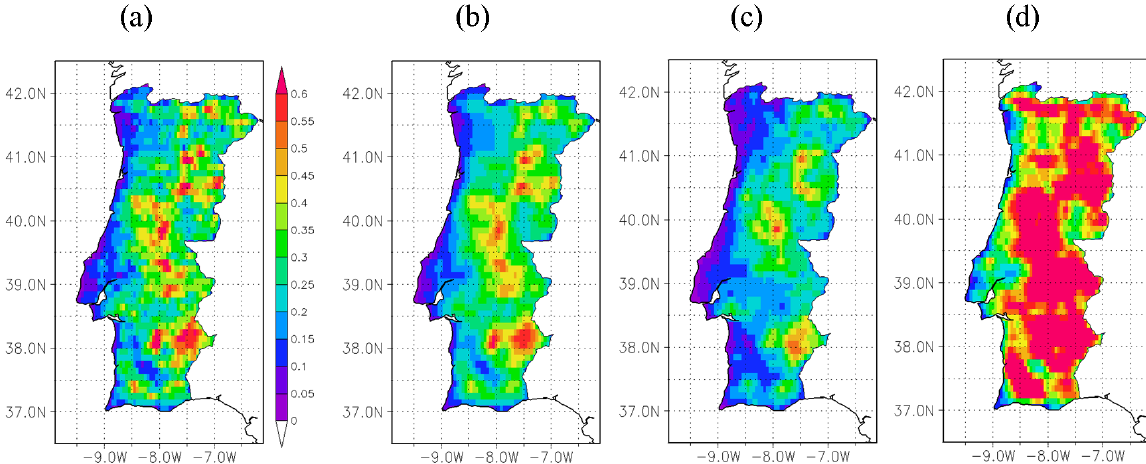
Fig. 7. Map of the (a) mean; (b) kernel-smoothed (KS; 0.5 ◦ latitude × 0.5 ◦ longitude) mean; (c) KS median of the CGD density; (d) KS percentile range (difference between the 90th and 10th percentiles) of the CGD density (number of dischargeskm − 2 yr − 1 ) over Portugal in